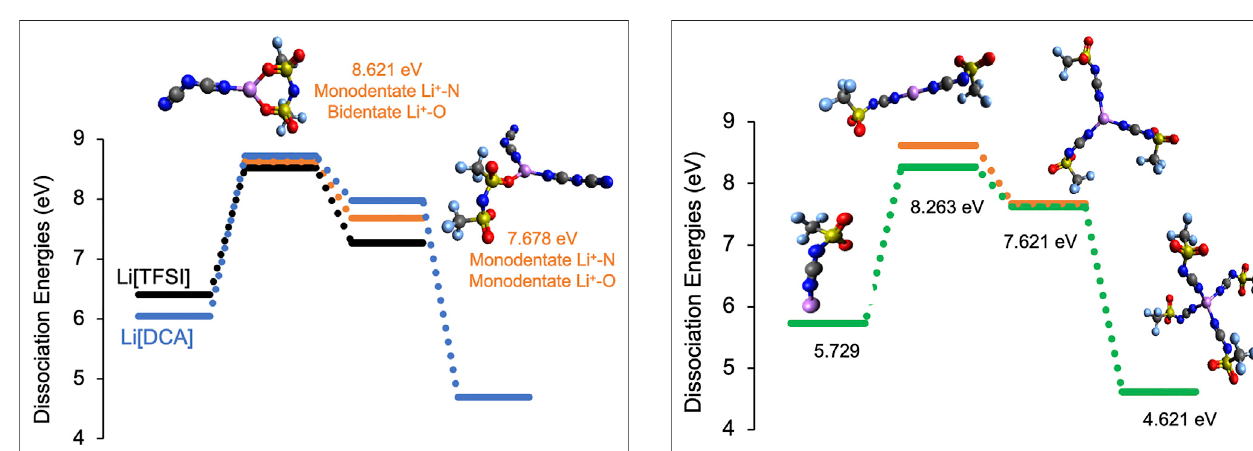
FIGURE 7 | Integral dissociation energies, E D , and representative structuresforLisolvateswith[DCA]/[TFSI]anions(orangebars)incomparison to Li-[TFSI] (black bars) and Li-[DCA] (blue bars). The color code for the atoms is as follows: red (oxygen), blue (nitrogen), yellow (sulfur), gray (carbon), purple (lithium), and light blue ( fl uorine).